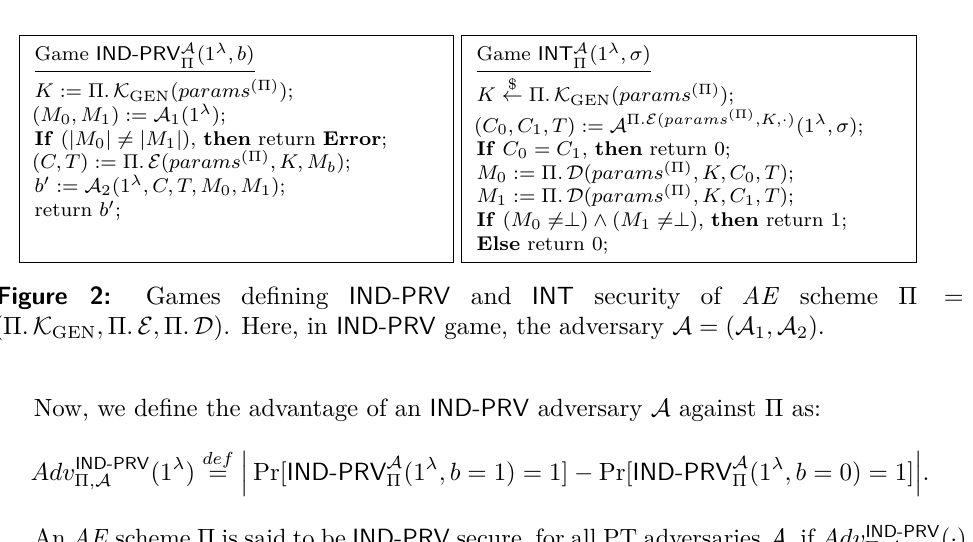
Key Assignment Scheme with Authenticated Encryption